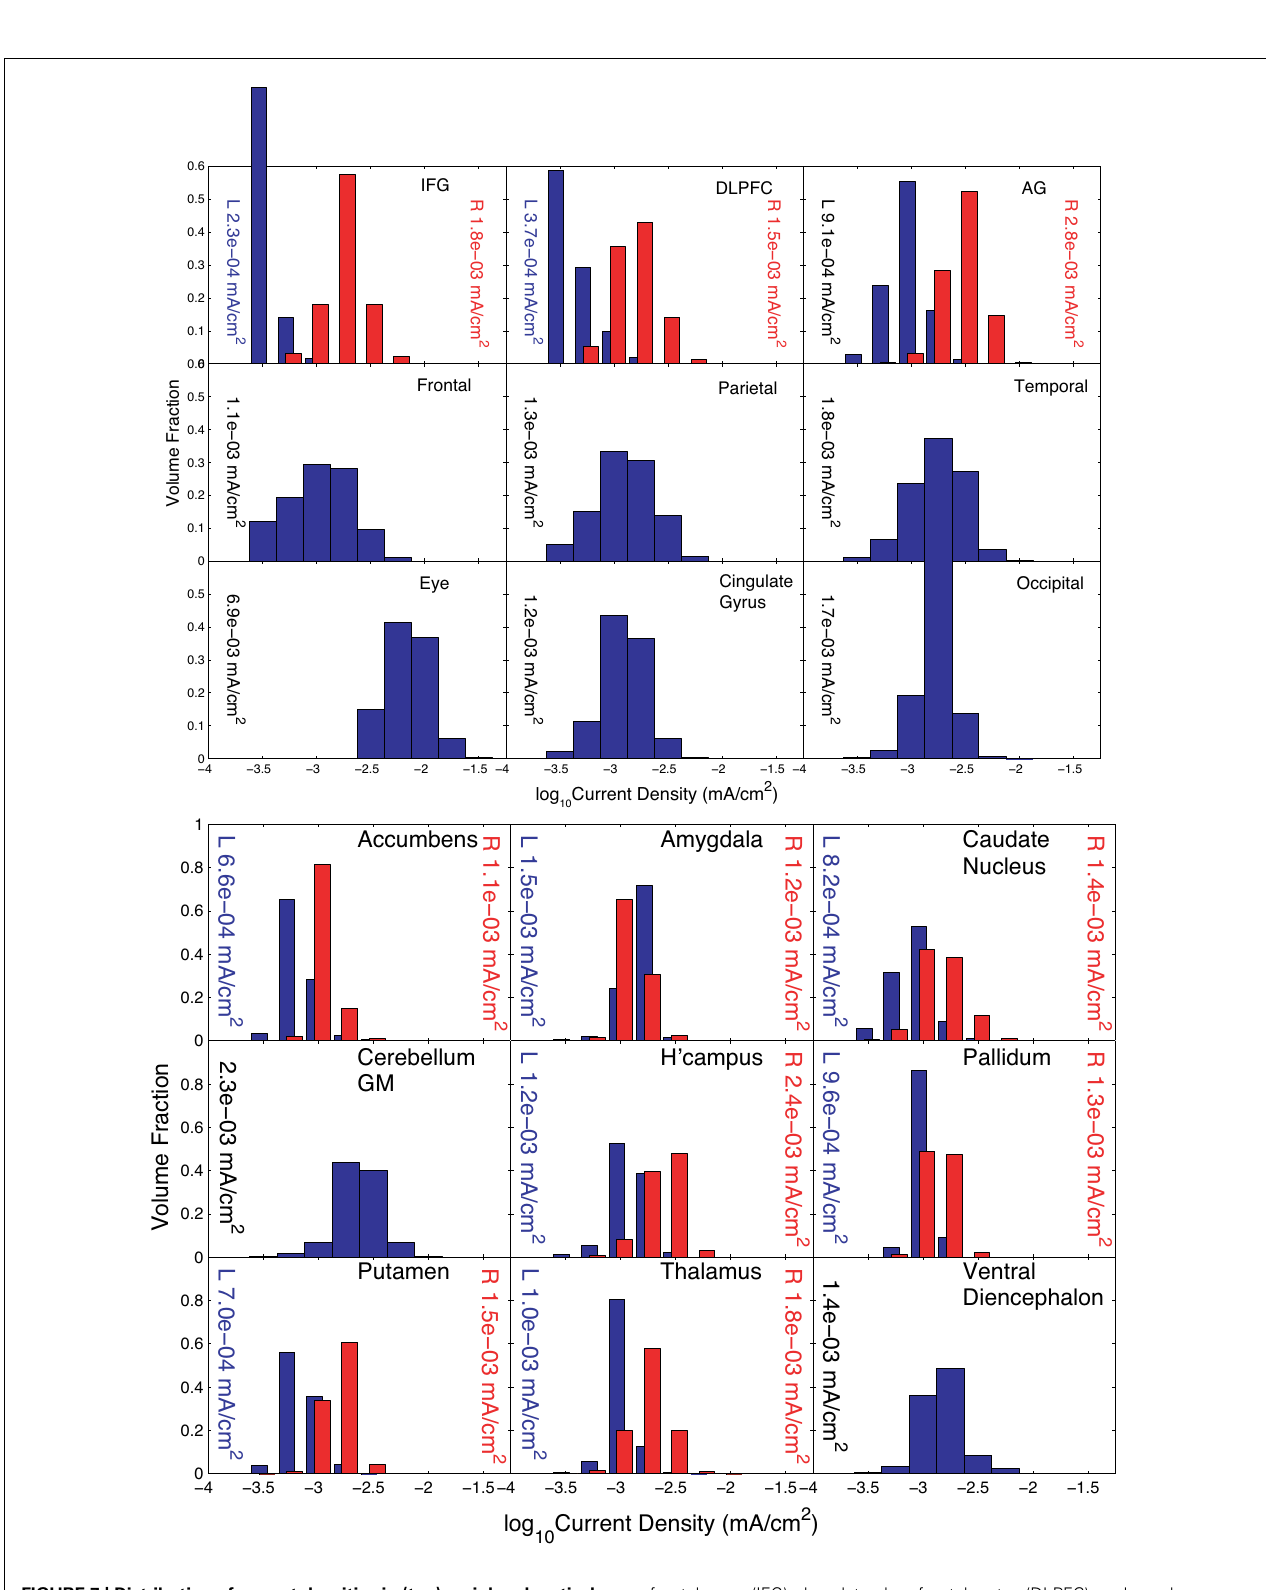
FIGURE 7 | Distribution of current densities in (top) peripheral cortical structures and (bottom) deep brain structures for Problem 3. Median values in each structure obtained using the optimal solution X are shown within each graph of the figure. IFG, DLPFC, and AG refer to the inferior